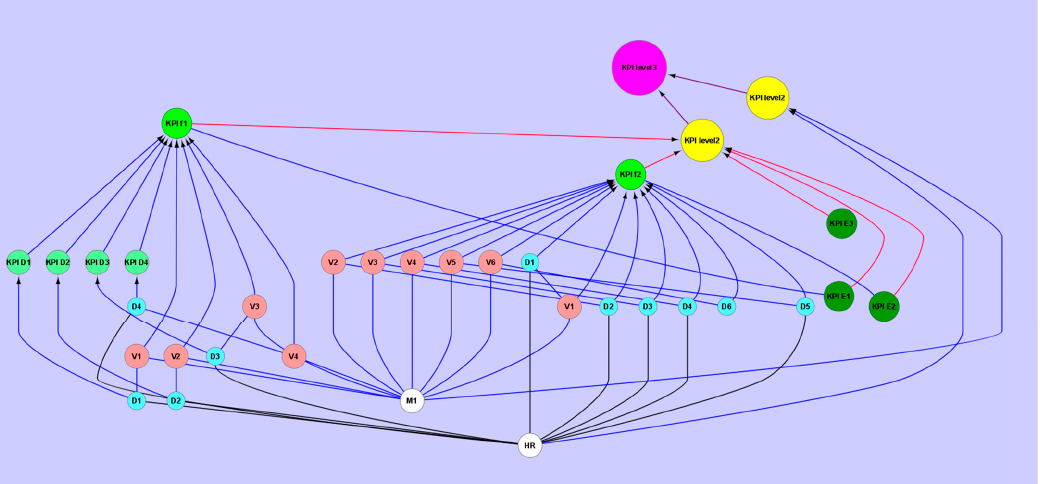
nodes was designed by Cytoscope